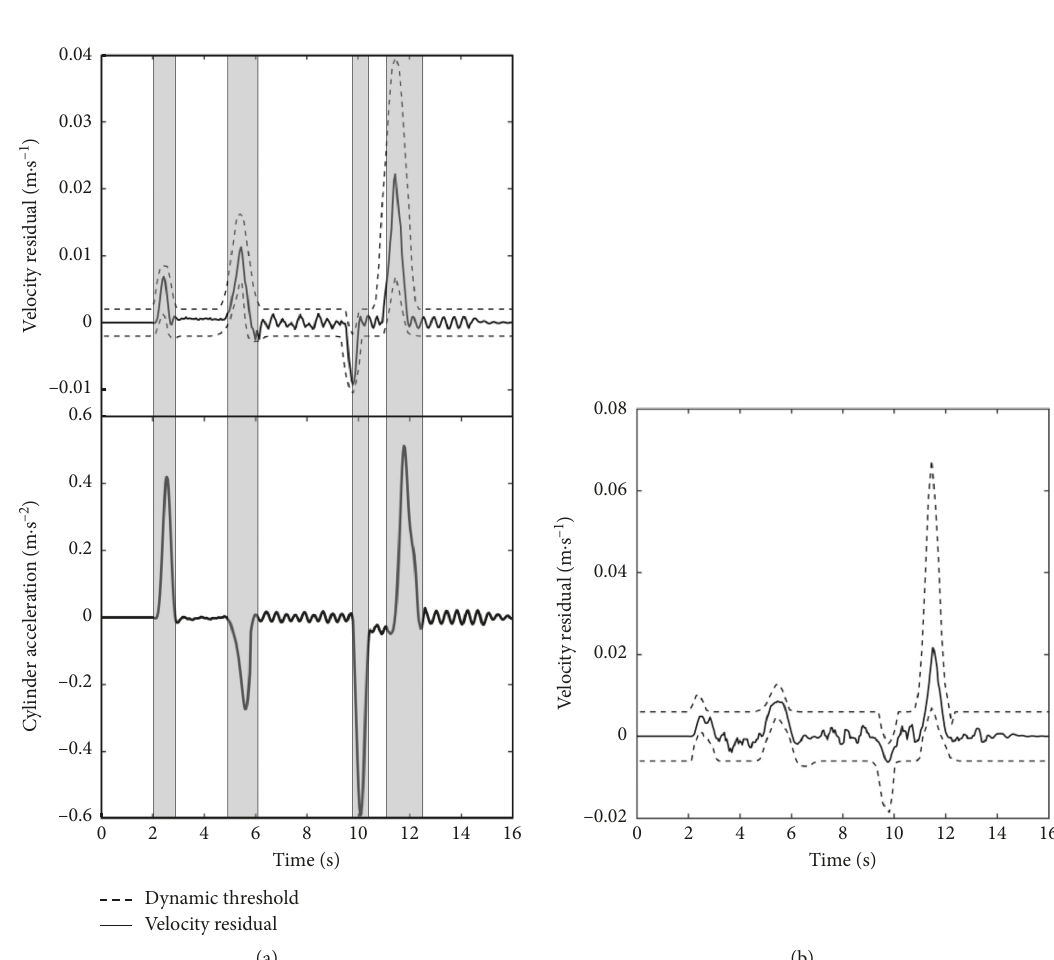
Figure 4: (a) Residuals of cylinder velocity and acceleration in normal state. (b) Residuals of cylinder velocity using method in